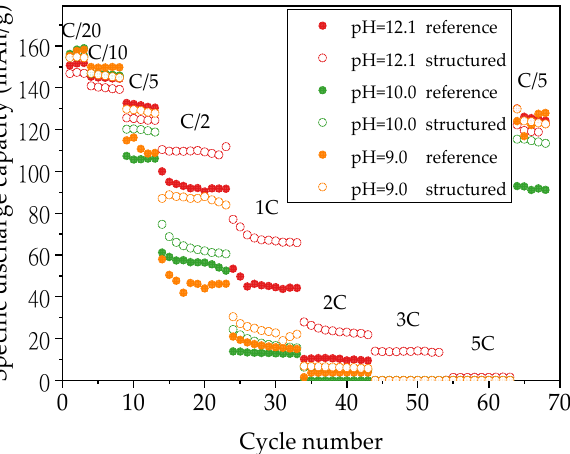
Figure 7. Specific discharge capacity of cells containing unstructured and laser structured thick-film electrodes which were produced with different slurry pH values.